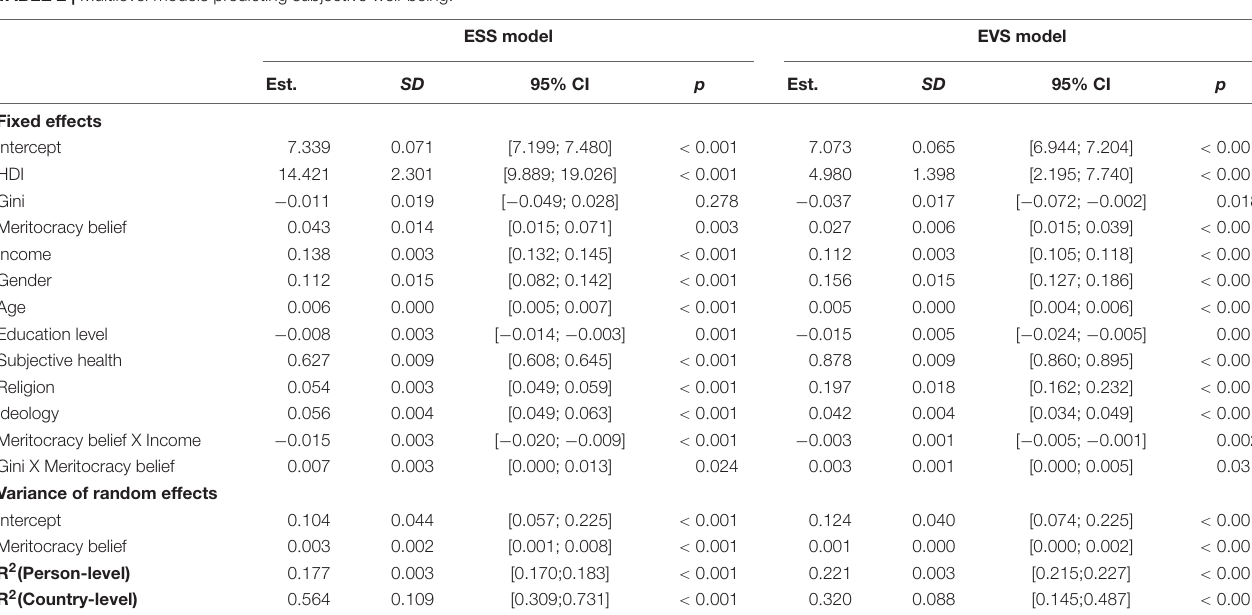
TABLE 2 | Multilevel models predicting subjective